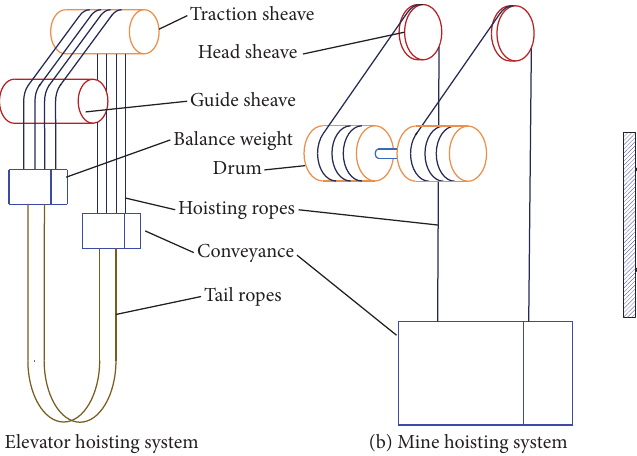
Figure 1: Parallel hoisting system.